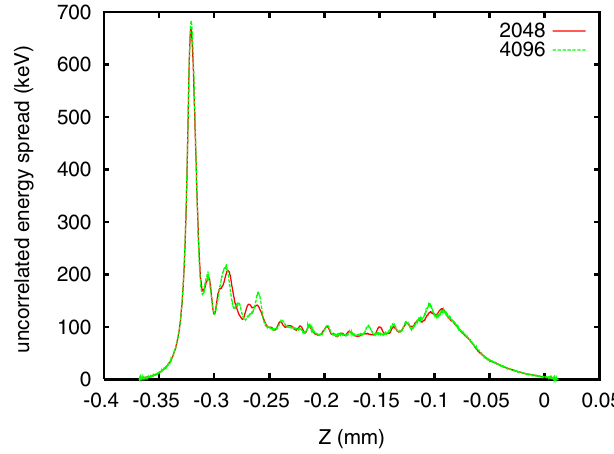
FIG. 8. (Color) Final energy spread from simulations using 2048 and 4096 grid